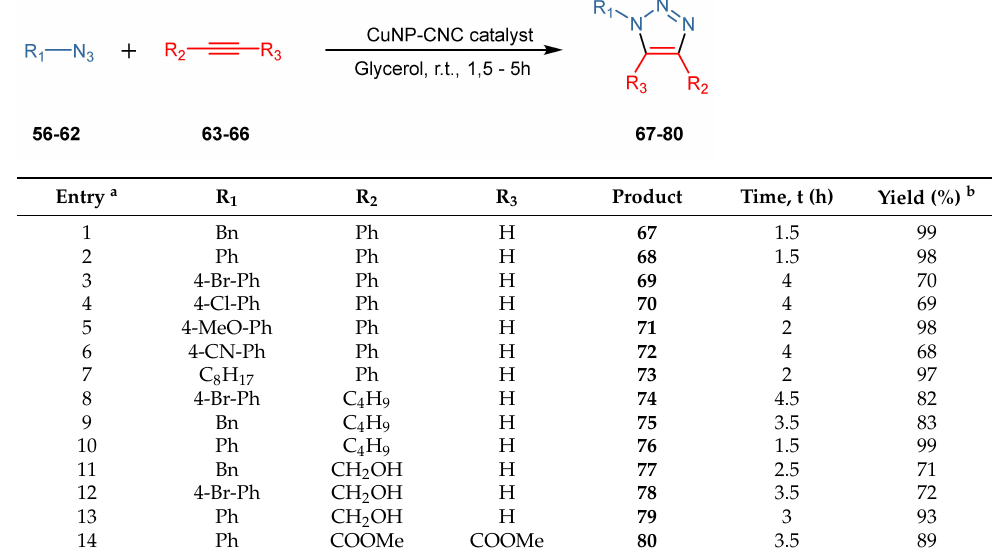
Table 6. CuNP-CNC-catalyzed 1,3-dipolar cycloaddition reaction between azides and